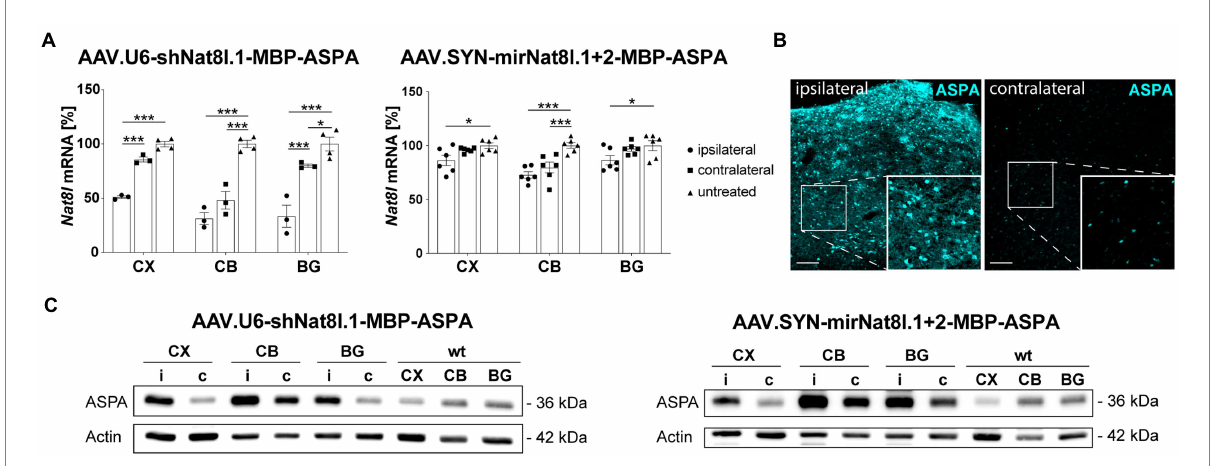
FIGURE 2 In vivo test of dual-function AAV vectors. AAV.U6-shNat8l.1-MBP-ASPA or AAV.SYN-mirNat8l.1 + 2-MBP-ASPA were injected unilaterally into striatum, thalamus, and cerebellum (3 × 10 9 vg per site) of heterozygous AKO mice. Nat8l knockdown (A) and ASPA expression (B,C) in the injected (ipsilateral) hemisphere were determined 4 weeks post injection and compared to the contralateral side as well as to untreated controls. (A) Nat8l mRNA levels in the cortex (CX), cerebellum (CB) and basal ganglia (BG; including striatum and thalamus) were determined employing qPCR with TaqMan probes specific for Nat8l and the housekeeping gene GusB ( n = 3 for AAV.U6-shNat8l.1-MBP-ASPA and n = 6 for AAV.SYN- mirNat8l.1 + 2-MBP-ASPA). Data represent mean ± SEM. * p < 0.05, *** p < 0.001; Two-way ANOVA with Bonferroni post-hoc test. (B) Immunohistochemistry for ASPA in the thalamus of AAV.SYN-mirNat8l.1 + 2-MBP-ASPA treated, heterozygous AKO mice (scale bar: 100 μ m). (C) Western blot depicting ASPA expression in the treated, ipsilateral (i) hemisphere and the untreated, contralateral (c) side of heterozygous AKO mice in comparison to untreated wt control